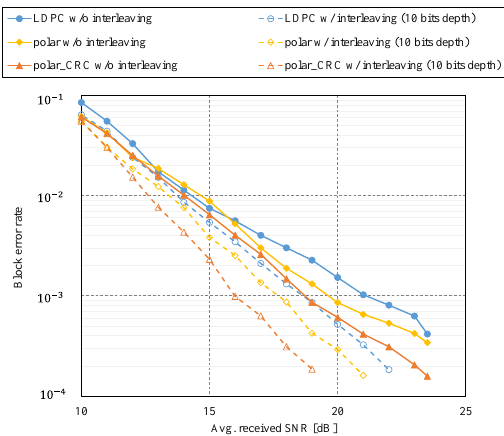
Figure 7. BLER performance with block interleaving (dashed lines) and without block interleaving (solid lines). The solid lines are the same ones shown in Figure 6b.